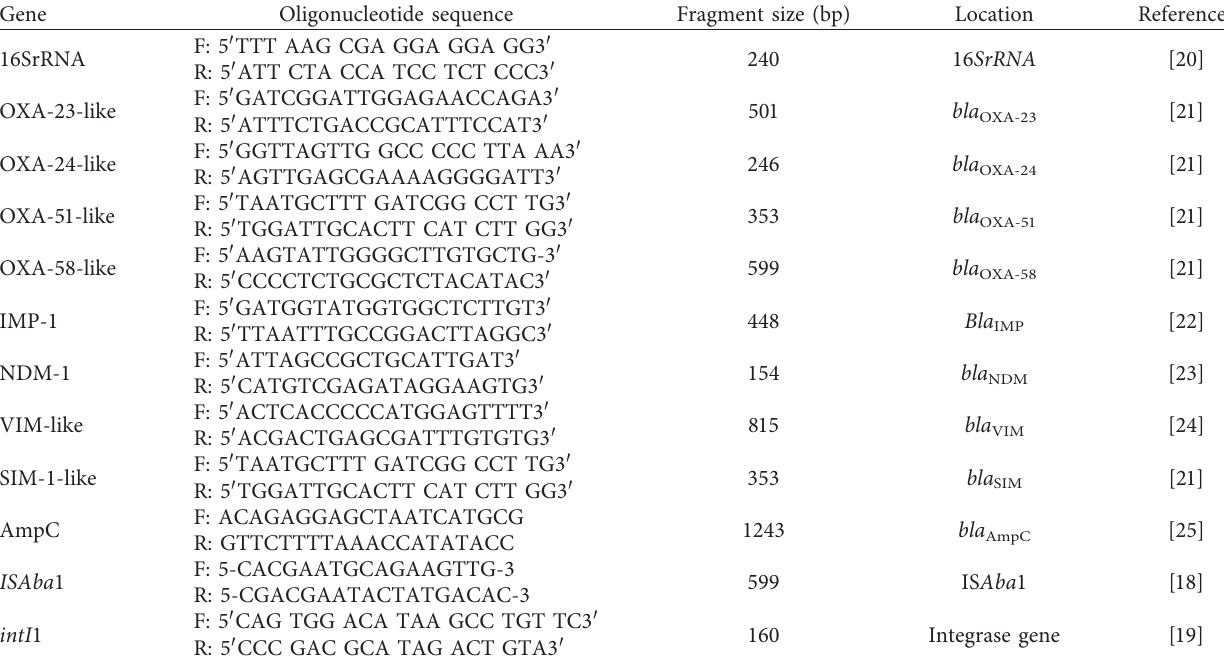
Table 2: List of primers used for PCR amplification of resistant genes.